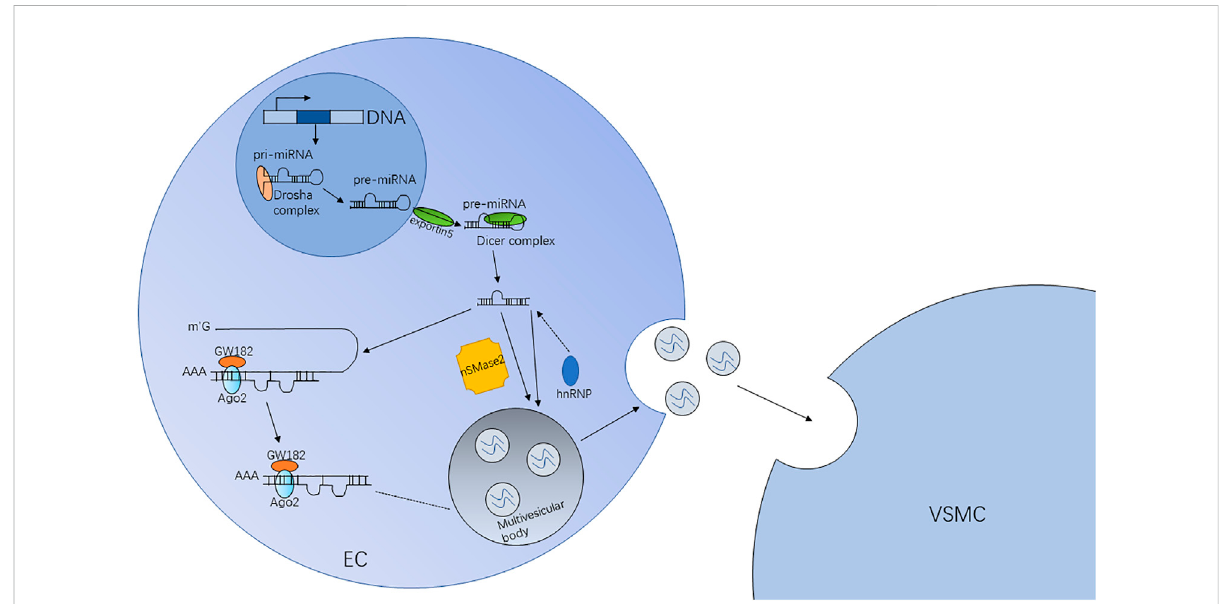
FIGURE 4 Pathway and mechanism of exosomal miRNAs. In ECs, miRNA genes are transcribed into primary miRNAs (pri-miRNAs) initially and then form precursor miRNAs (pre-miRNAs) processed by the Drosha complex. Because of the exportin5 complex, the pre-miRNAs are exported into the cytoplasm. Finally, through the digestion of the Dicer complex, the pre-miRNAs become mature. Mature miRNAs are sorted into exosomes depending on the nSMase2-dependent pathway, the hnRNP pathway,